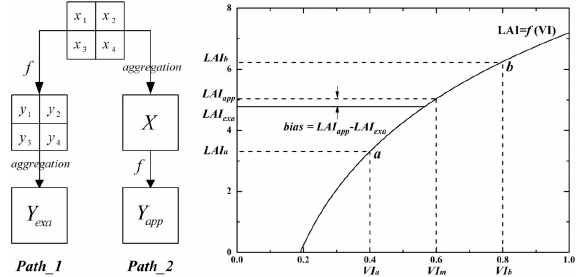
Figure 1. Schematic flowchart for the up-scaling process: f is a function relating y to x ; x i ( i = 1, 2, 3, 4) is the value of each pixel at the original high resolution and X is their average. Suppose x 1 = x 2 = VI a , x 3 = x 4 = VI b , then X is VI m representing the vegetation index value of the coarse spatial resolution pixel, and y i is the corresponding LAI value. The subscript exa means the exact value and app represents the approximated value of the coarse resolution